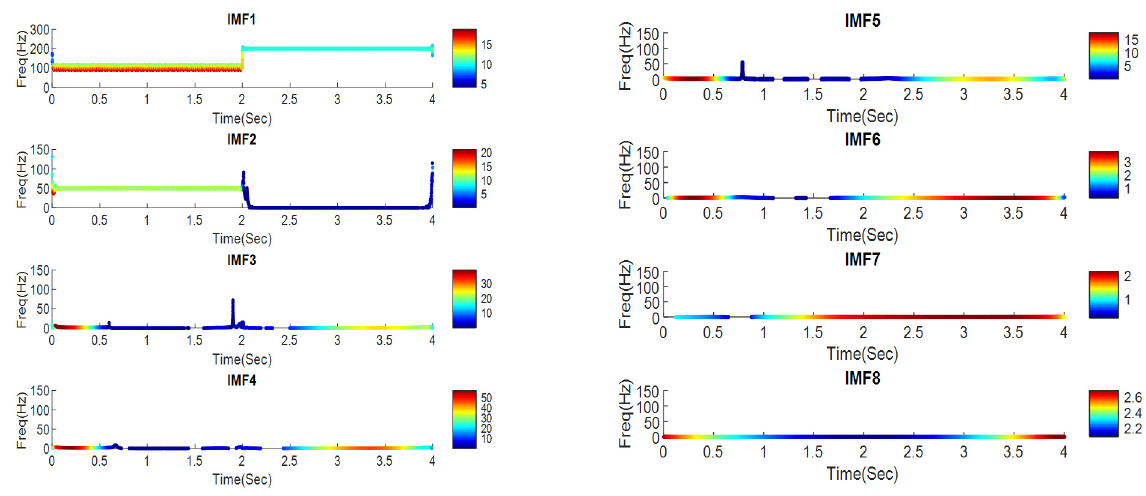
Figure 3. Instantaneous frequencies of the multicomponent nonstationary signal.